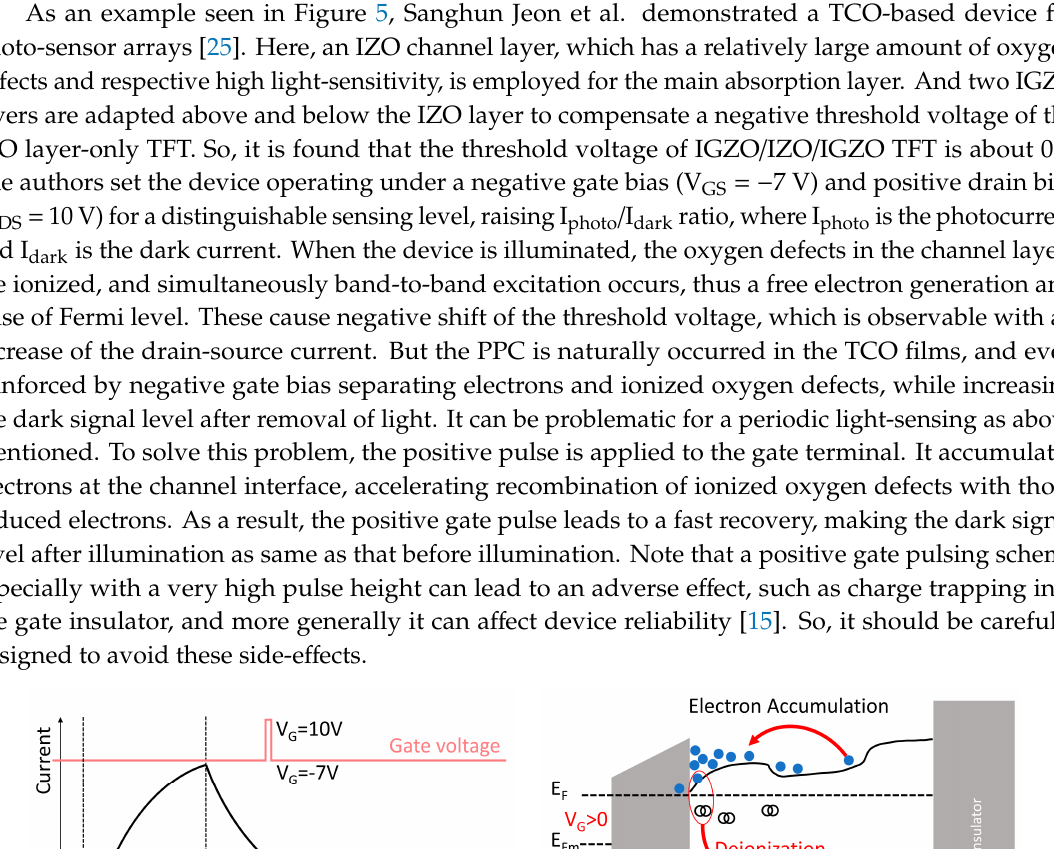
Figure 4. ( a ) Conceptual diagram to describe an optical memory-action and light-reactivity through the ionization of oxygen defects. ( b ) Indication of functional regions of the current as a function of time for each device.